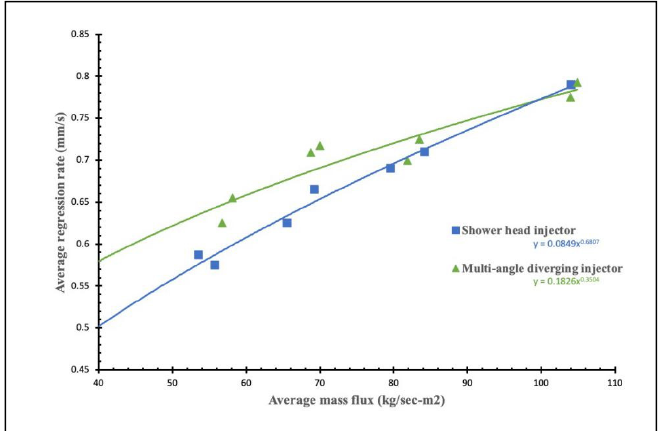
Figure 5. Average regression rate vs. average mass flux using the two injector designs for PVC fuel. Int. J. Turbomach. Propuls. Power 2020 , 5 , x FOR PEER REVIEW